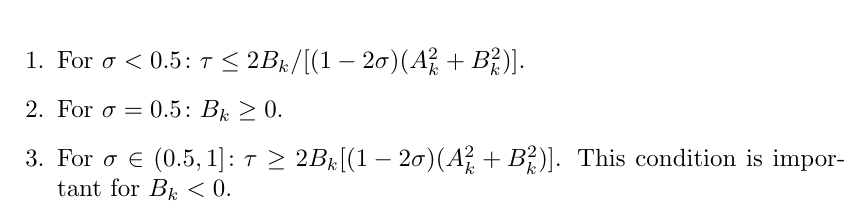
Figure 6. Discrete (old) eigenvalues in the plane (Re μ, Im μ ), N = 268, L = 113 . 7, γ = 1 . 1934982, δ = 0, I = 0.